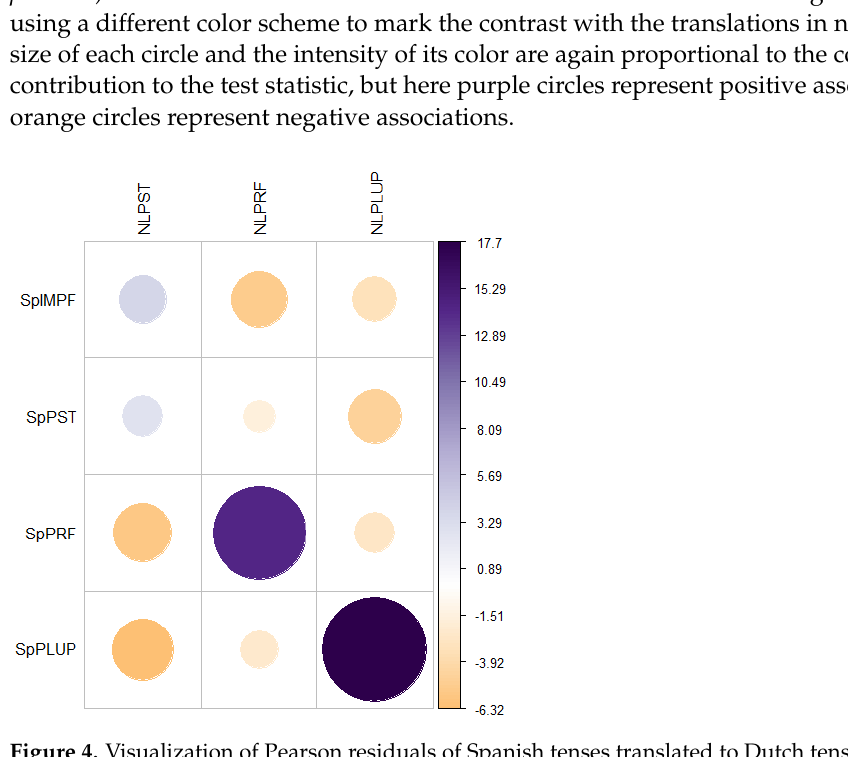
Figure 6. Visualization of Pearson residuals of Spanish tenses translated to French tenses in dialogue. The same picture as before emerges: the one-to-one translations carry most of the weight. However, Figures 4–6 also reflect our three observations from above. First, although there is a negative association between the Spanish simple past and the Dutch present perfect in Figure 4, this is much weaker than between the Spanish present perfect and the Dutch simple past. This crucially indicates that the translation of the Spanish simple past to the Dutch present perfect is not just arbitrary, even though the percentages of the two translation pairs in Table 2 are apparently similar. Further, note that the negative association between the Spanish imperfect and the Dutch present perfect is much stronger. That is, Spanish imperfects reject a Dutch present perfect translation much harder than Spanish simple pasts do. Second, we mentioned that the number of Spanish present perfects translated to English simple pasts is relatively high. Figure 5 shows a negative association between